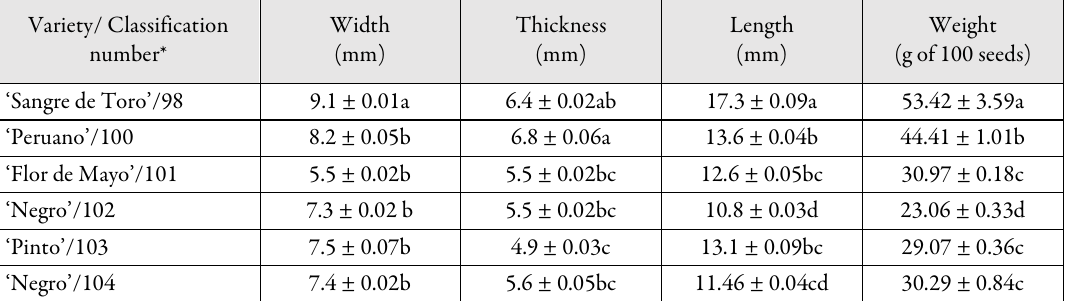
Table 2. Morphometric characteristics of several common bean varieties from Morelos State, Mexico Variety/ Classification ‘Sangre de